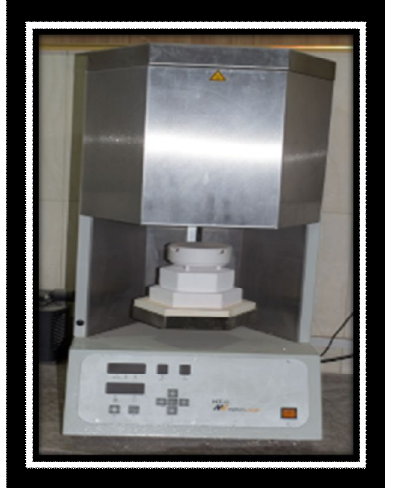
Figure 7: Sintering oven (HT-S MV